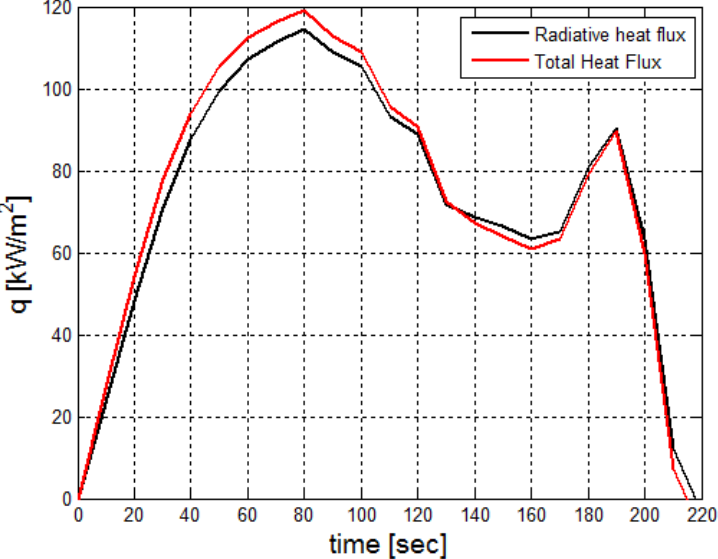
Figure 21. Radiation heat flux produced by the Heptane burner.